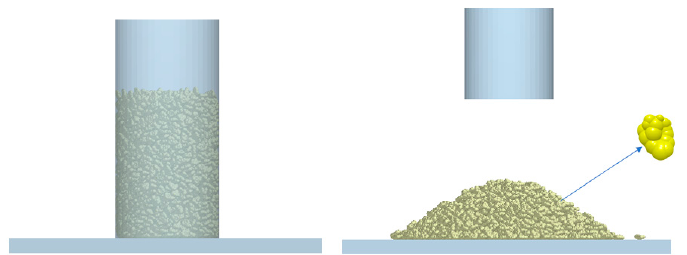
Figure 4. The simulation process of the repose angle for cracking kernels.